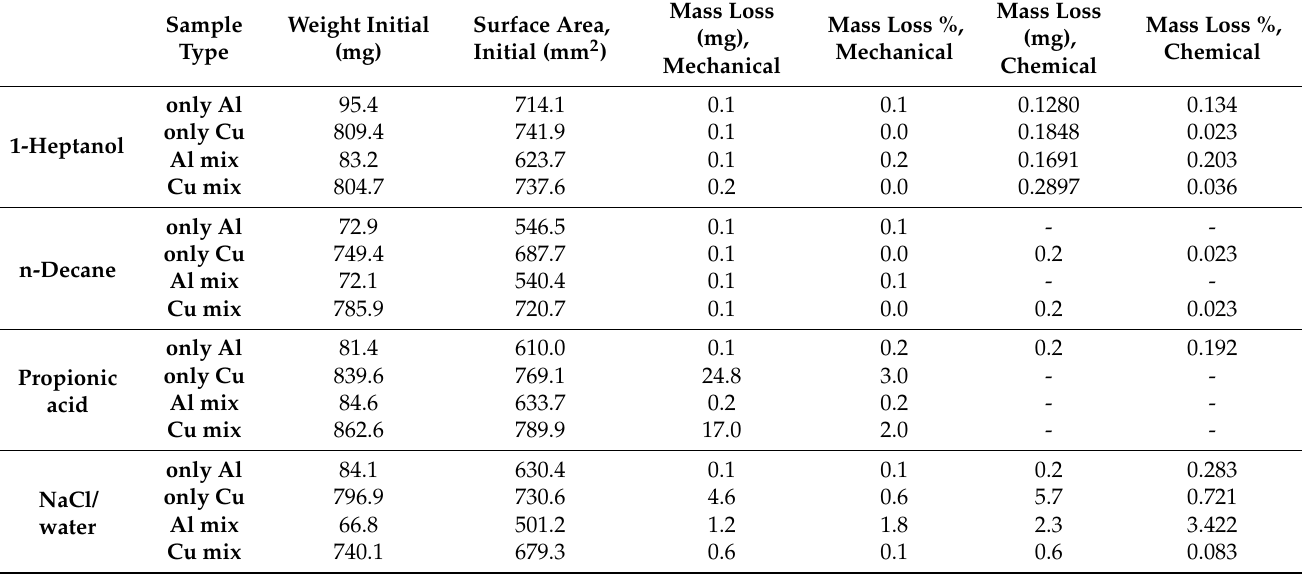
Table 4. Summary of experimental results for the material compatibility tests with